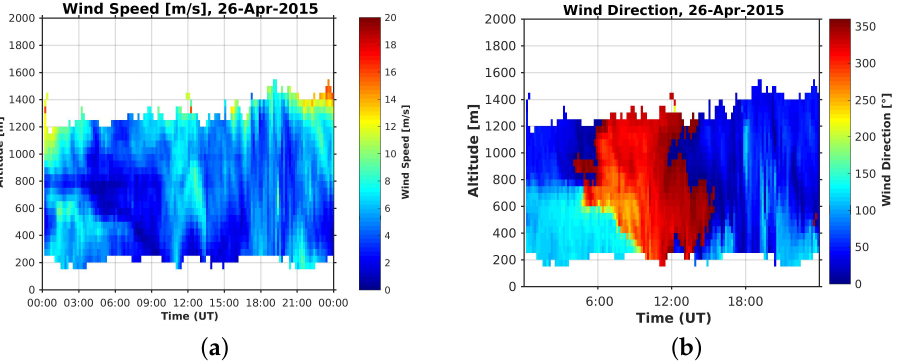
Figure 8. Example of a sharp change in wind speed and direction. ( a ) Wind speed of 26 April 2015, ( b ) Wind direction of 26 April